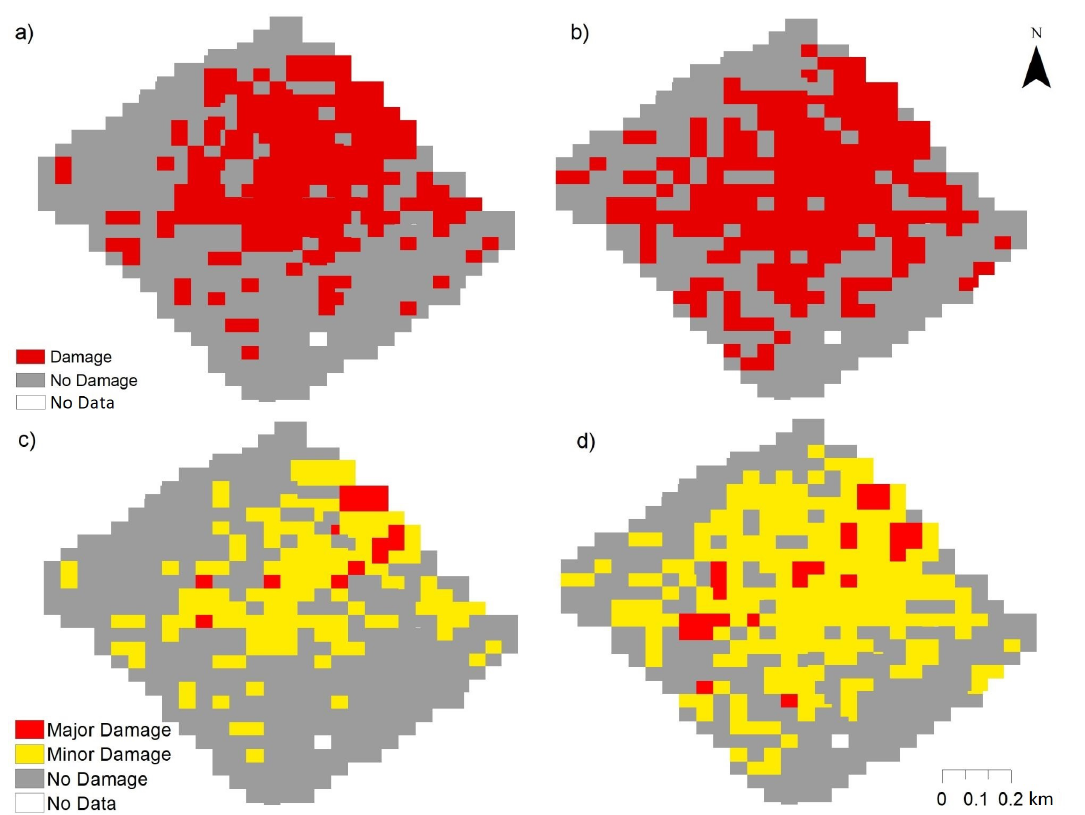
Figure 8. Tornado damage heatmaps from image classification: ( a ) binary inference results, ( b ) binary ground truth, ( c ) multi-class inference results, and ( d ) multi-class ground